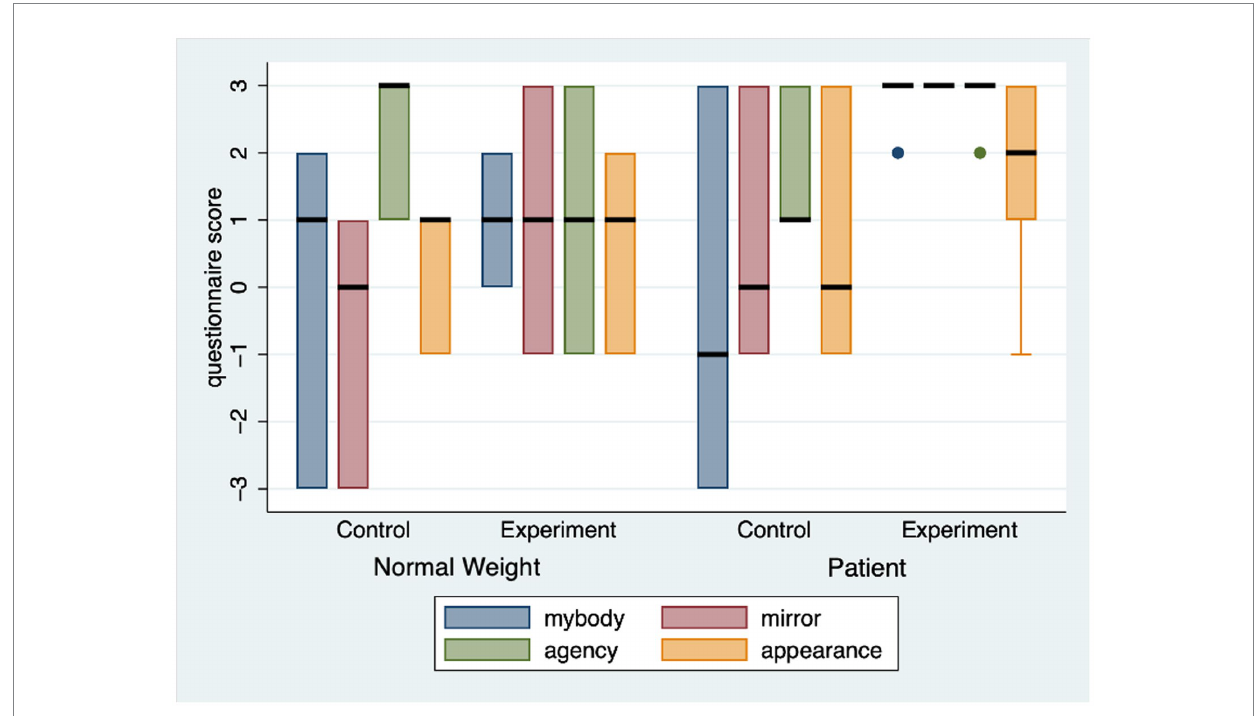
FIGURE 1 Item scores from Body ownership questionnaire comparing Control and Experimental group, separately distributed in normal weight participants and